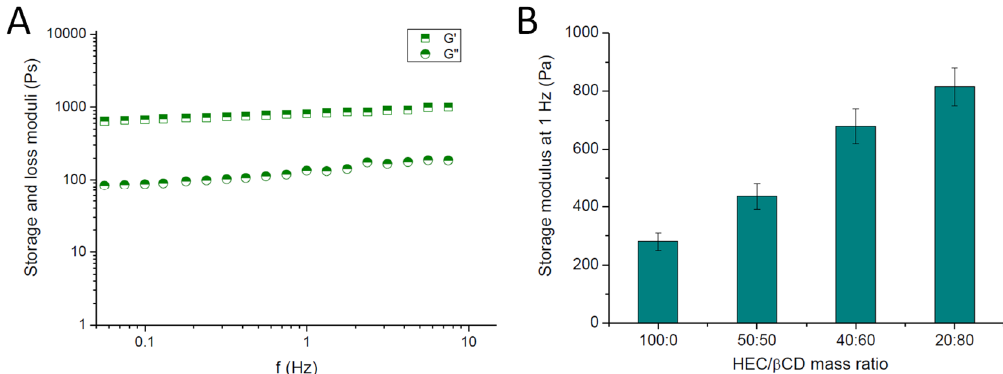
Figure 4. Storage (G ) and loss (G ) moduli of HEC/β-CD (2:8) cryogels as a function of frequency ( A ), and effect of HEC/β-CD mass ratio on the storage modulus of cryogels ( B ).